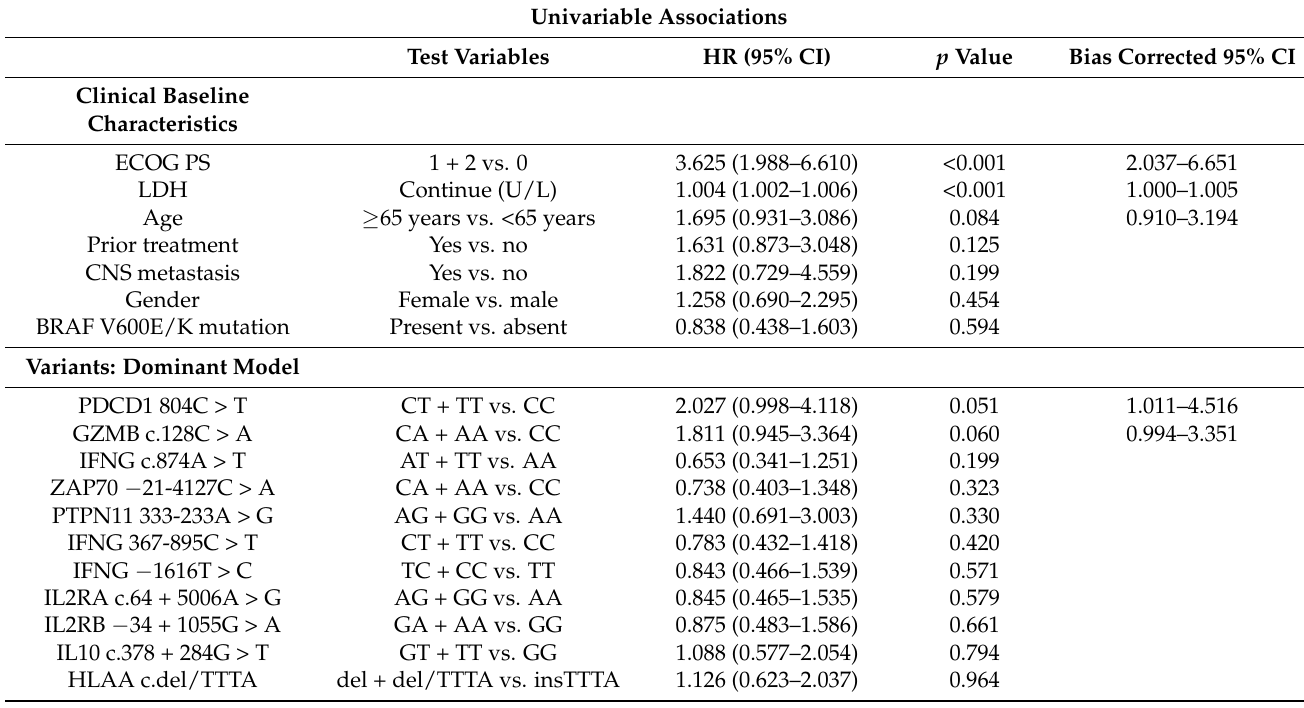
Table 4. Univariable and multivariable associations of clinical baseline characteristics and SNPs with OS. Univariable